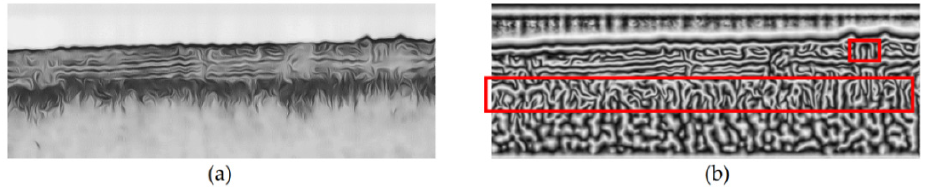
Figure 4. Characteristics of processed SBP images. ( a ) shows the diffusion filtered SBP image. ( b ) shows the local phase image of ( a ).